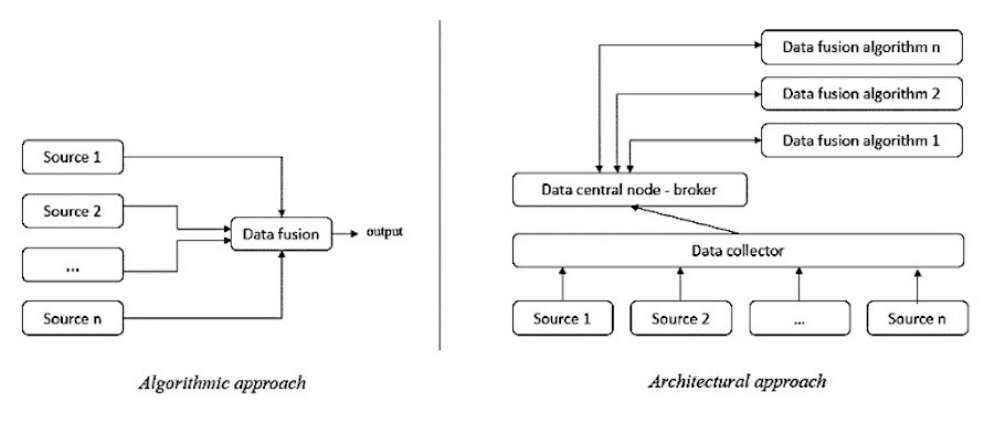
Figure 1. Data fusion from an algorithmic or architectural perspective.